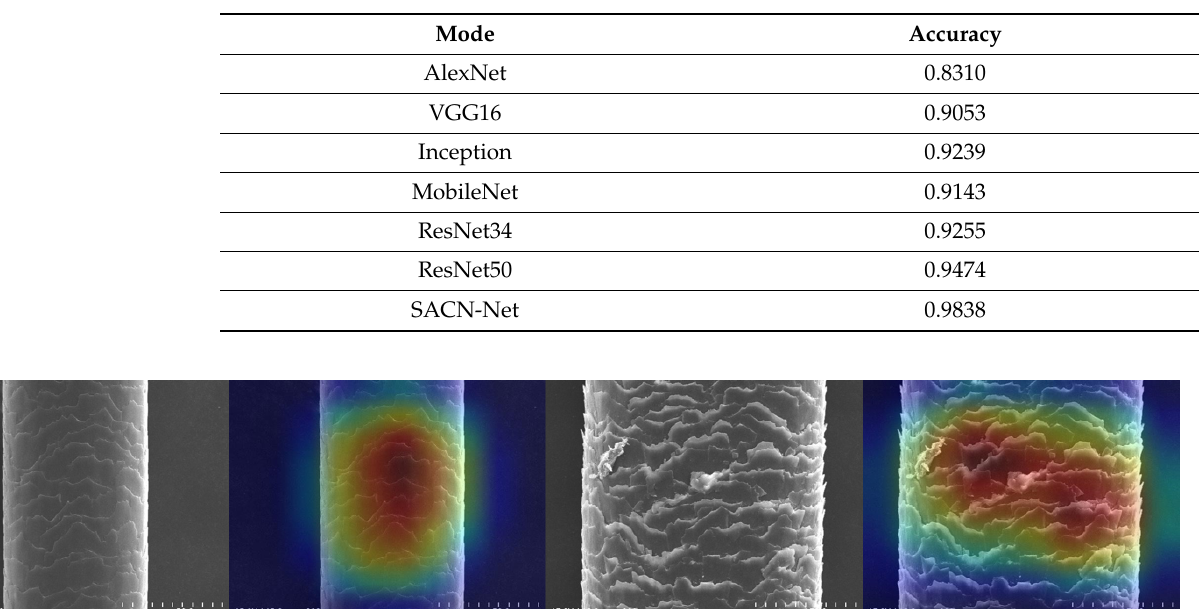
Table 2. Comparison of accuracy of different models.